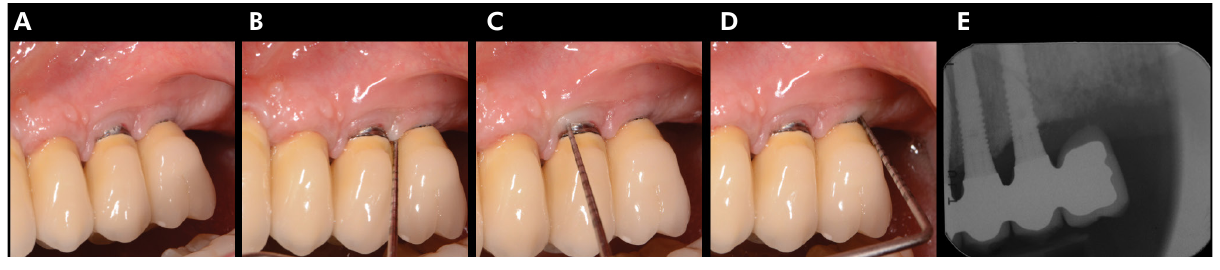
Figure 4. Clinical (a-d) and radiographic (e) view at the 12-month follow-up.